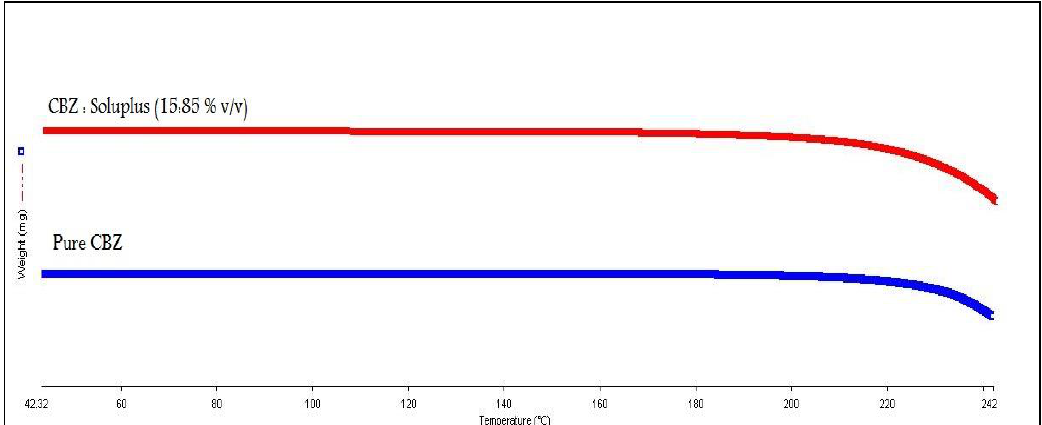
Figure 1. Thermo-gravimetric analysis (TGA) data for pre-extrusion for physical mixture and pure carbamazepine (CBZ).